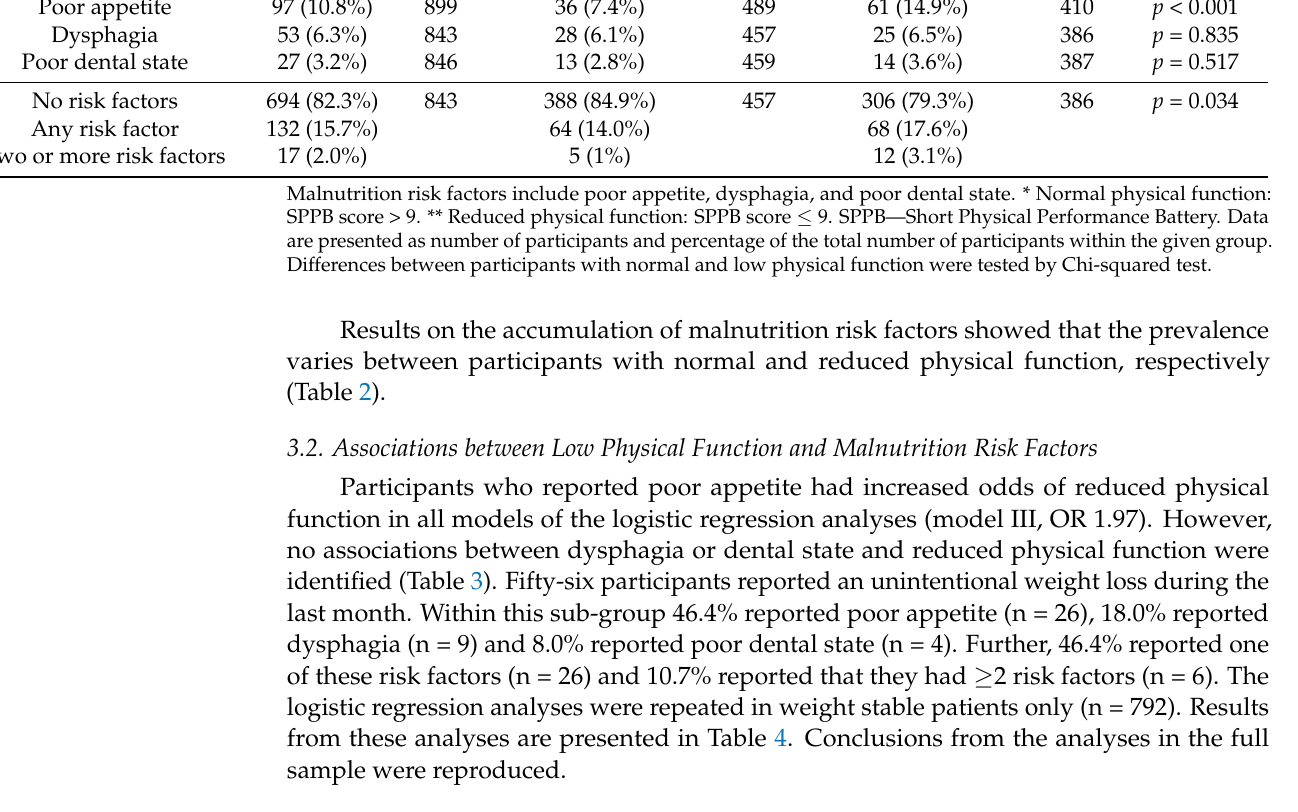
Table 3. Associations between reduced physical function and malnutrition risk factors. Logistic Regression Analyses Reduced Physical Function